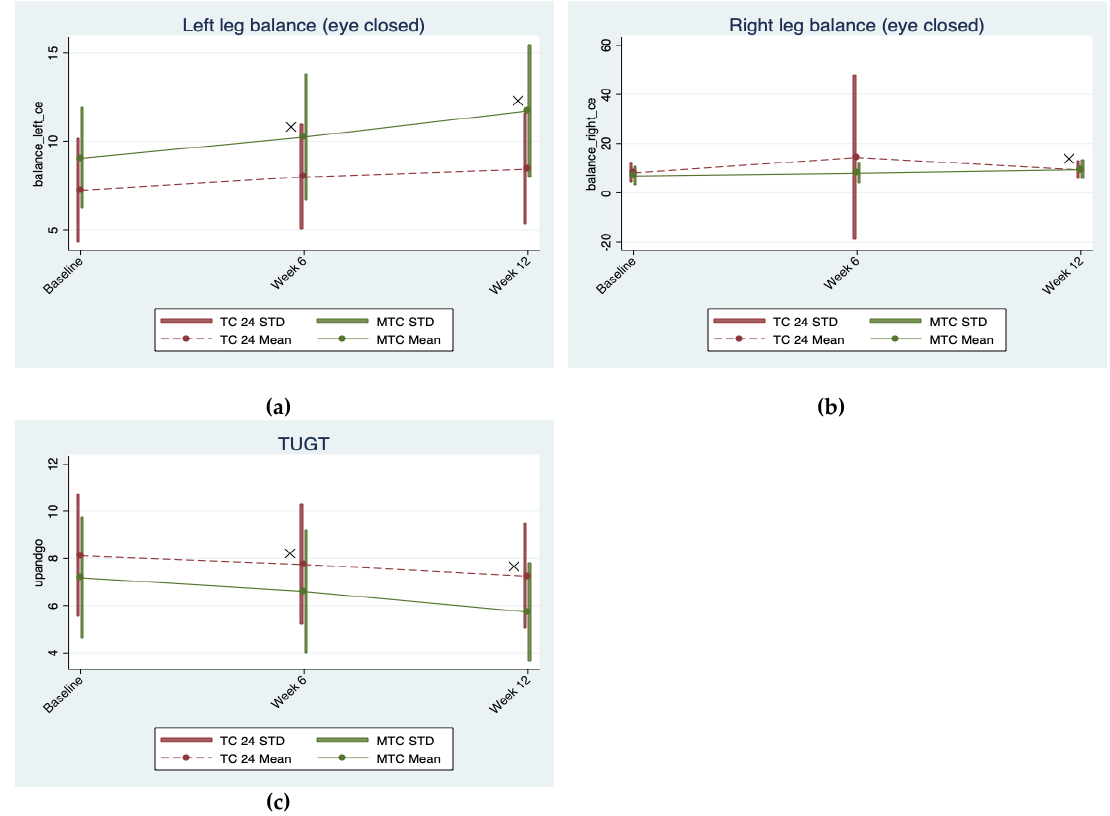
Figure 3. Interaction plots for indices (( a ) left leg balance, ( b ) right leg balance, and ( c ) TUGT) of